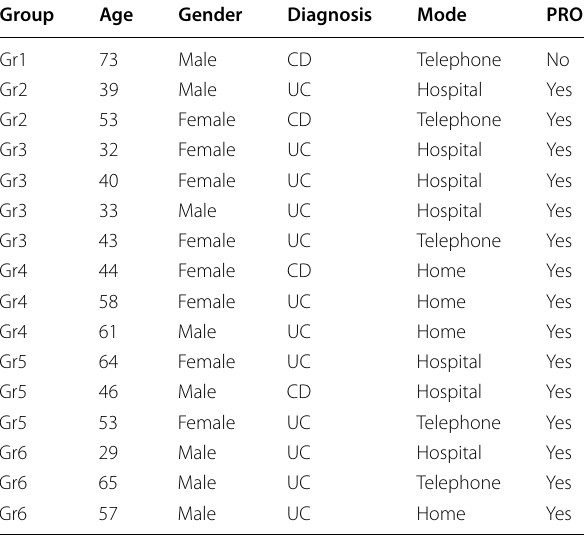
UC ulcerative colitis, CD Crohn’s disease